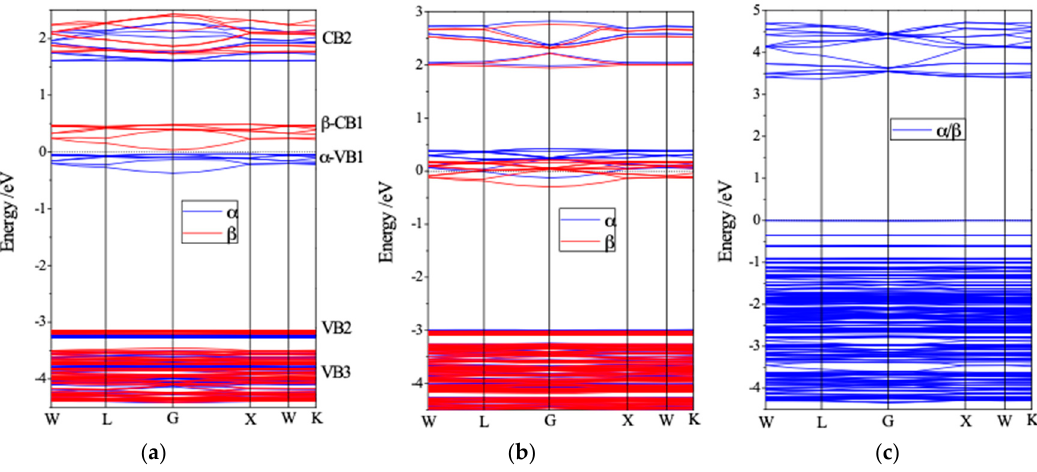
Figure 2. Calculated band structures of ( a ) aAg 0.29 Li 0.71 -LSX, ( b ) bAg 0.43 Li 0.57 -LSX, and ( c ) cAg 0.29 Li 0.71 -LSX. The energy is referenced by setting Fermi energy level as zero. VB: valence band; CB: conduction band.